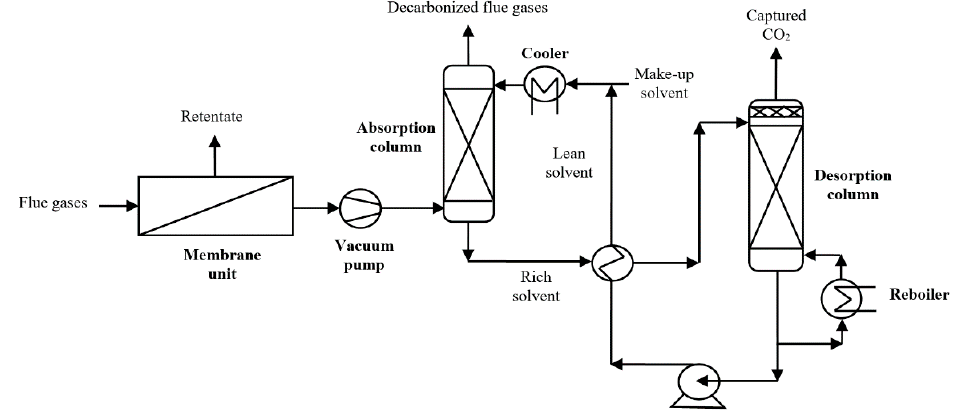
Figure 3. Layout of hybrid system with pre-concentration membrane unit using vacuum pump.